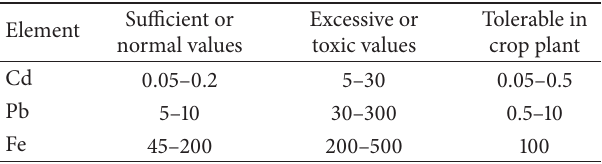
Table 9: Translocation factor (TF) and enrichment factor (EF) for plant species growing around ex-iron mine. Plant